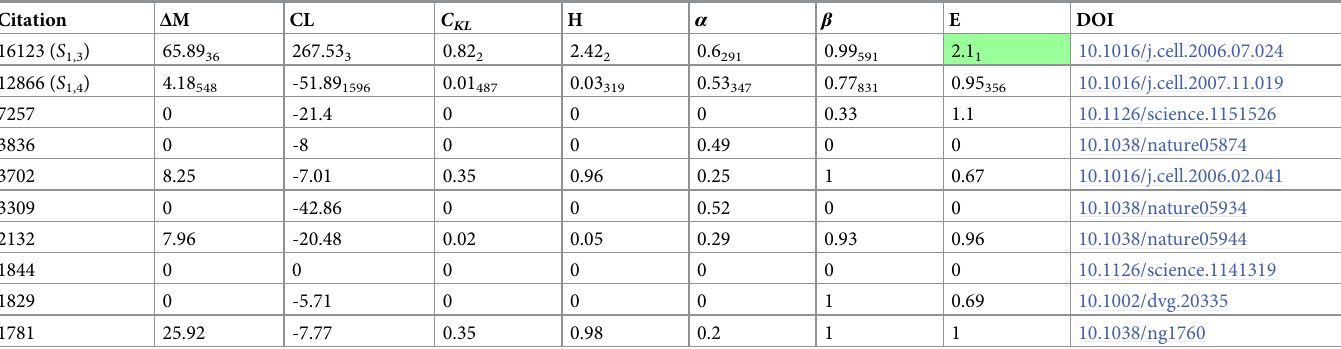
Table 4. Case 1. The SVA scores of top-10 most cited papers in the network (2001-2007). SVA score ranges: The ranges of the obtained SVA metric scores are: Δ M :0.0– 89.36, CL :-76.24–494.69, C